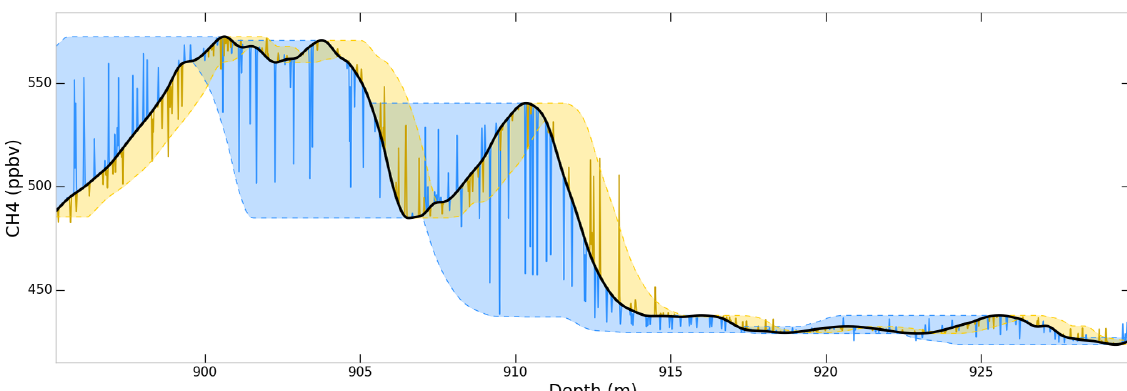
Figure 4. Modeled layered trapping artifacts. The black curve represents the results of smooth trapping. Spikes correspond to a single stochastic realization of the layered trapping with CFA smoothing. Blue stands for early closure and yellow for late closure. Blue shaded areas correspond to the range of concentration anomalies for early closure anomalies up to 2 standard deviations (depth anomaly of 5m corresponding to an age anomaly of 415 years). Yellow shaded areas correspond to late closure anomalies with 25% of the early closure extent (depth anomaly of 1 . 25m corresponding to an age anomaly of 104